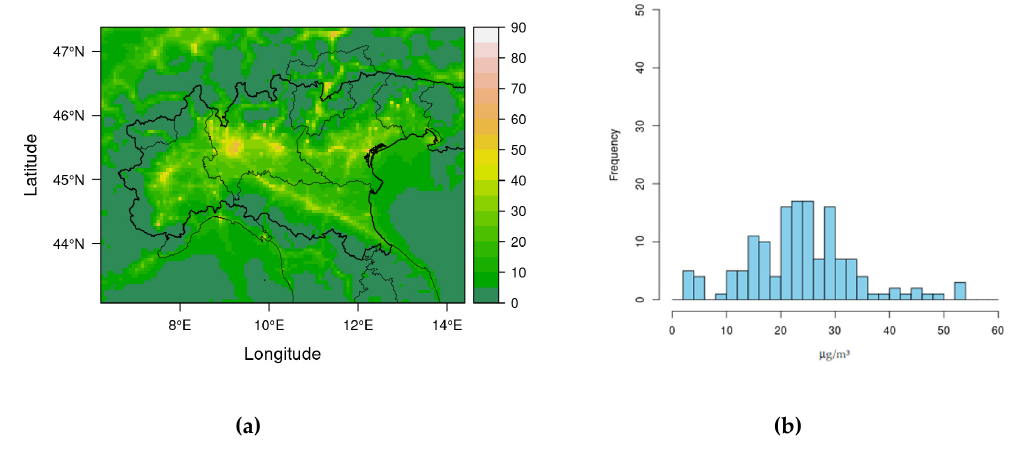
Figure 9. Baseline NO 2 : ( a ) ground field of annual average concentration ( μ g/m 3 ); ( b ) frequency distribution of annual average concentration in background stations.